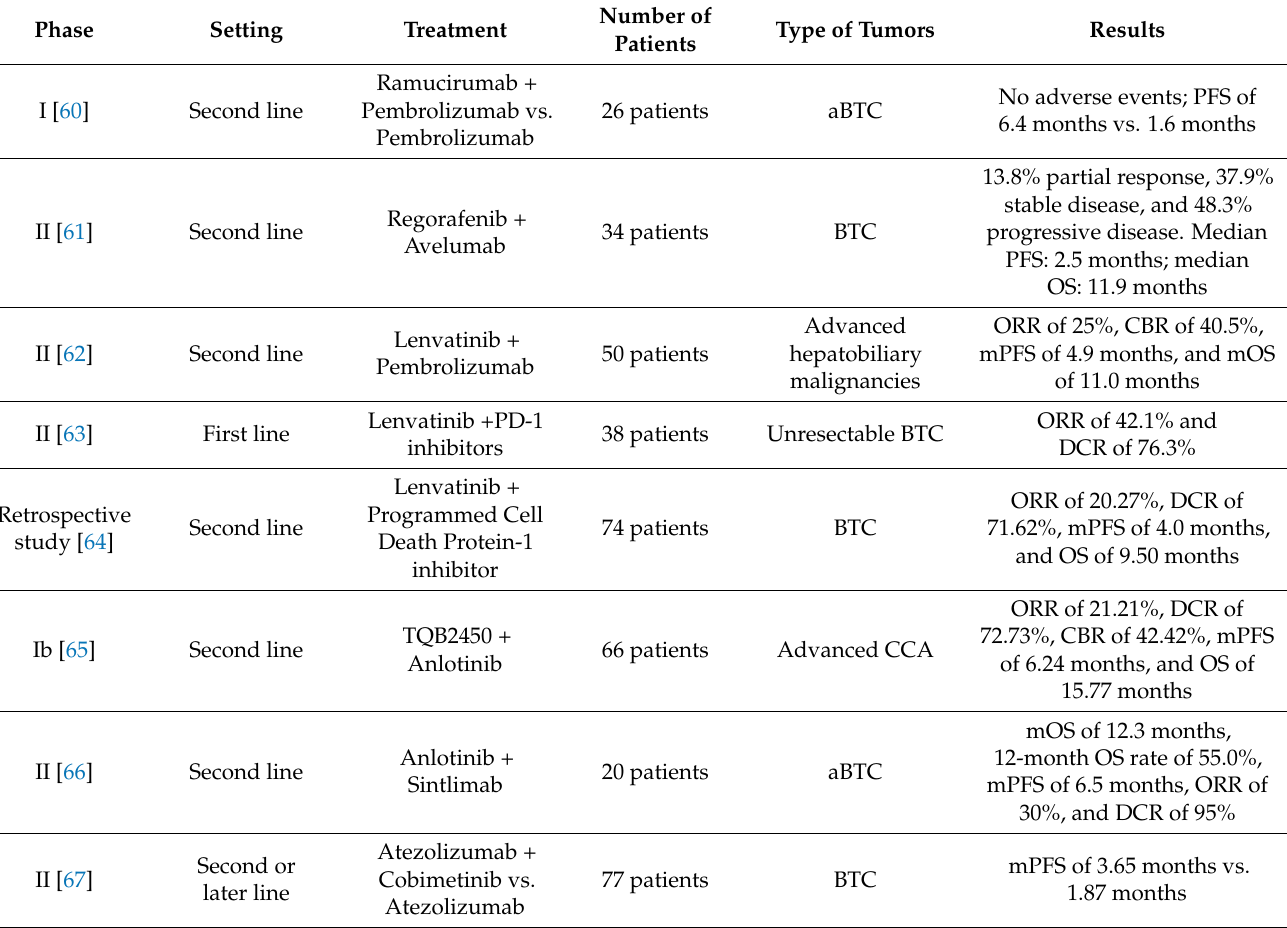
Table 1. Comprehensive table of studies assessing immunotherapy and antiangiogenic combined therapy with reported results in biliary tract cancer. Abbreviations: BTC, biliary tract cancer; aBTC, advanced biliary tract cancer; CCA, cholangiocarcinoma; GBC, gallbladder cancer; PFS, progression- free survival; OS, overall survival; CBR, clinical benefit rate; DCR, disease control rate; ORR, overall response